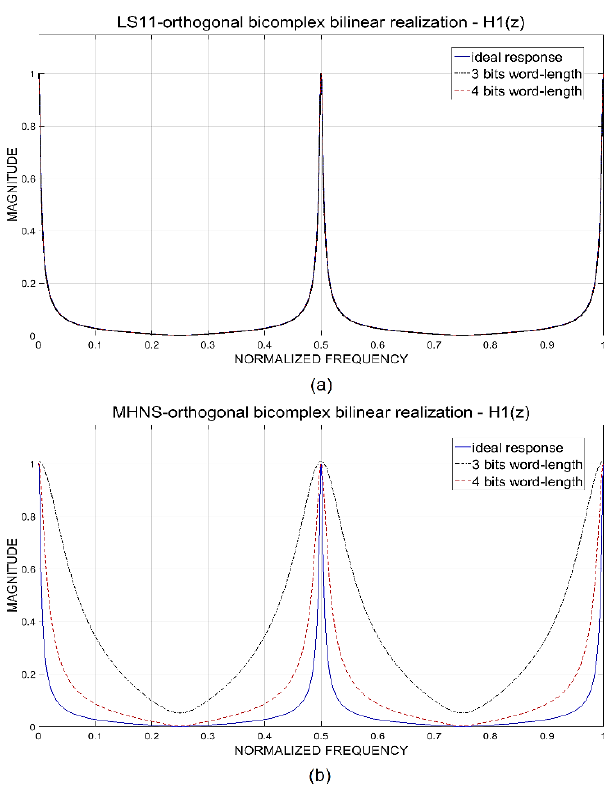
Fig. 8. Magnitude responses of the bicomplex orthogonal real-coefficient functions H 1 ( z ) for different word-lengths: (a) LS 11-based; (b) MHNS -based.